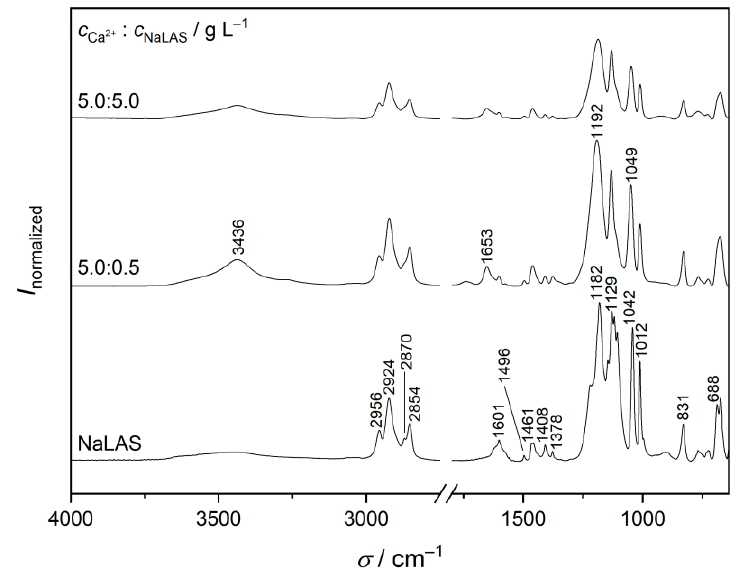
Figure 4. Traces of infrared spectra of sodium linear alkylbenzene sulfonate (NaLAS) and precipitates formed by adding CaCl 2 to solutions of the surfactant, at two different Ca 2+ :NaLAS weight ratios. Characteristic vibrations of NaLAS taken from Ref. [56] are labelled. Also shown are the stretching (3436 cm –1 ) and scissoring (1653 cm –1 ) vibration modes, respectively, of hydrating water. The intensities were normalized such that the highest value in each spectrum is 1.00.